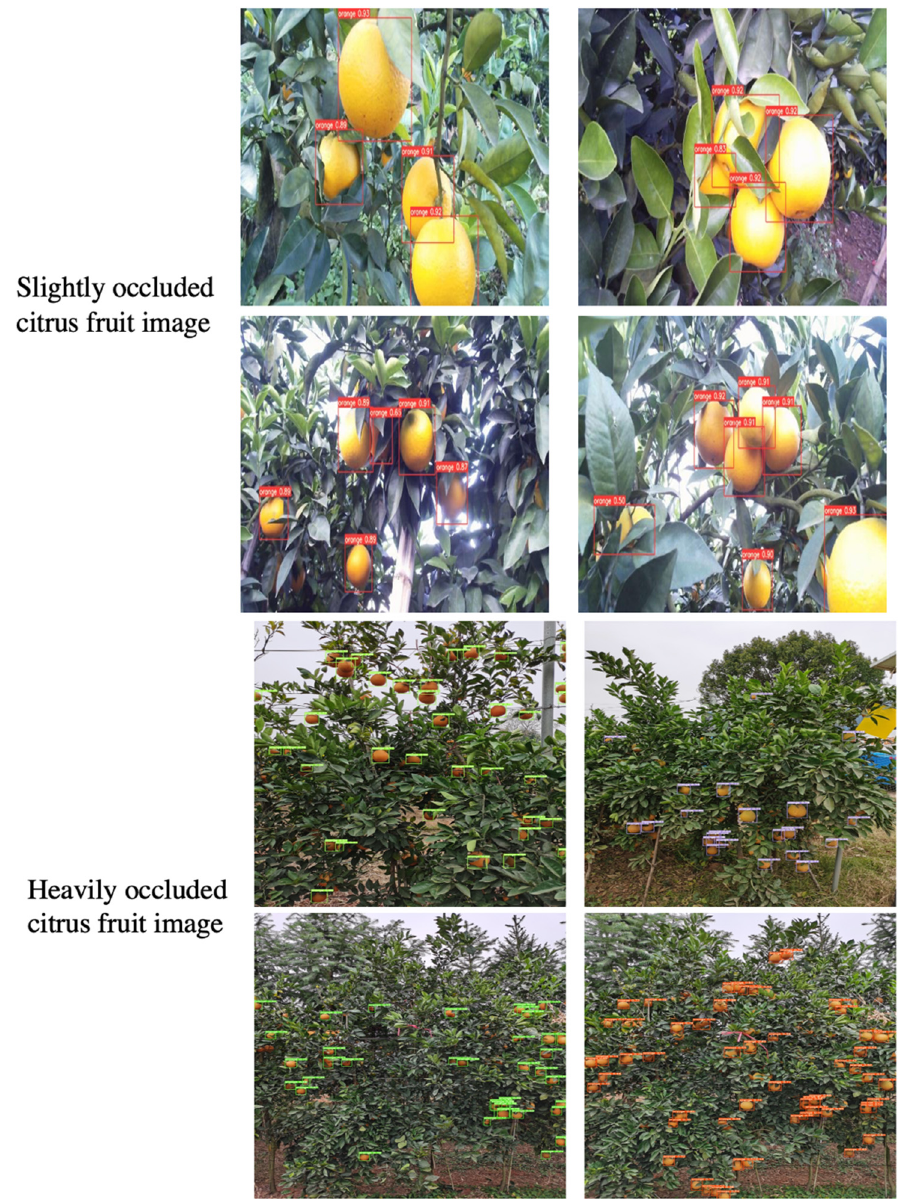
Figure 9. We visualized the detection effect of citrus fruits under different occlusion levels, In the figure, the words above all detected citrus fruits are "orange" and their confidence .